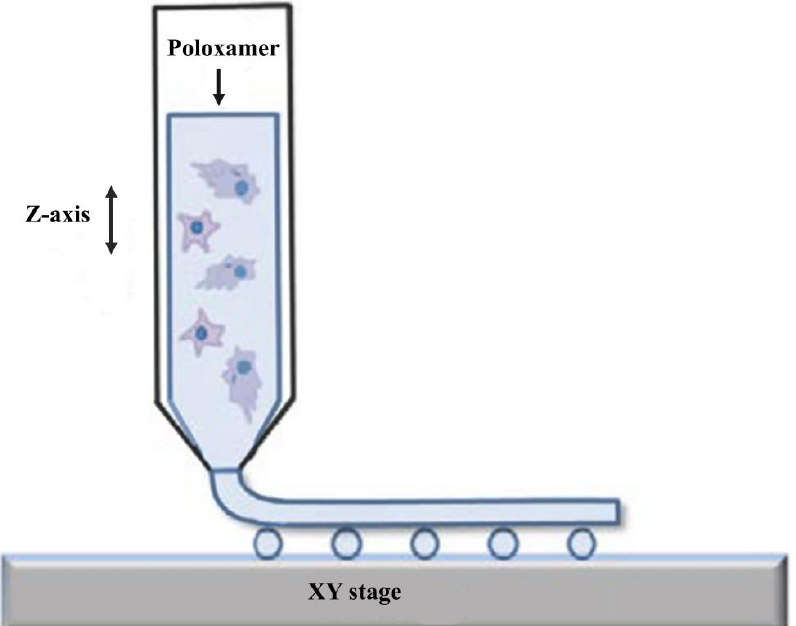
Figure 5. Schematic illustration of the fabrication process for the obtaining of cell-laden poloxamer constructs. The image has been taken from the publication by Gioffredi et al. [27] with permission.